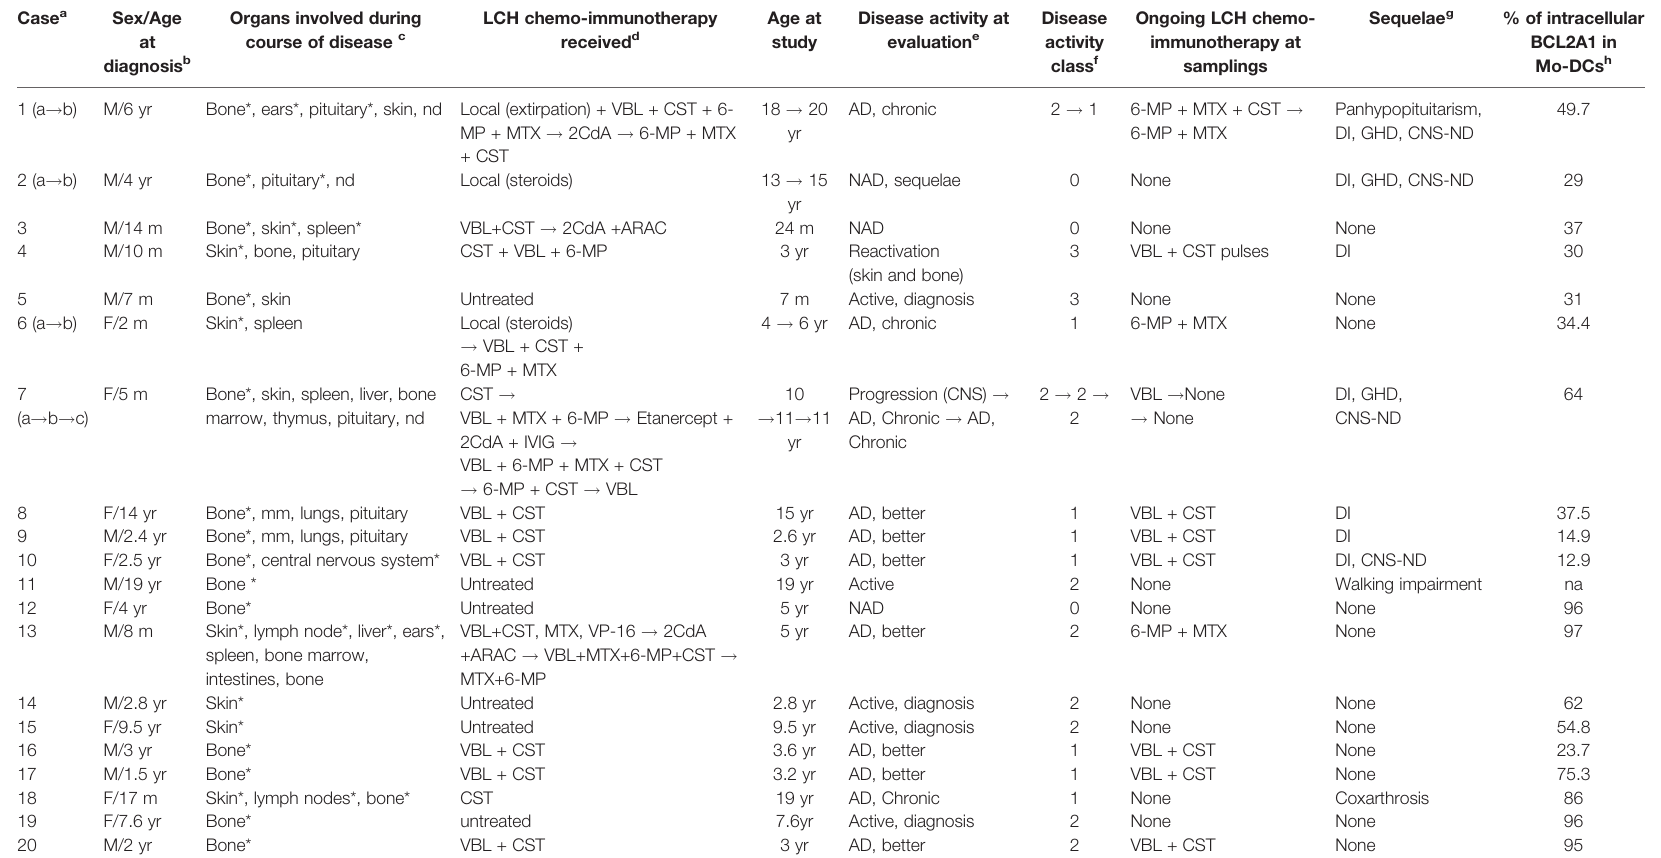
TABLE 1 | Main features of the patients with LCH.